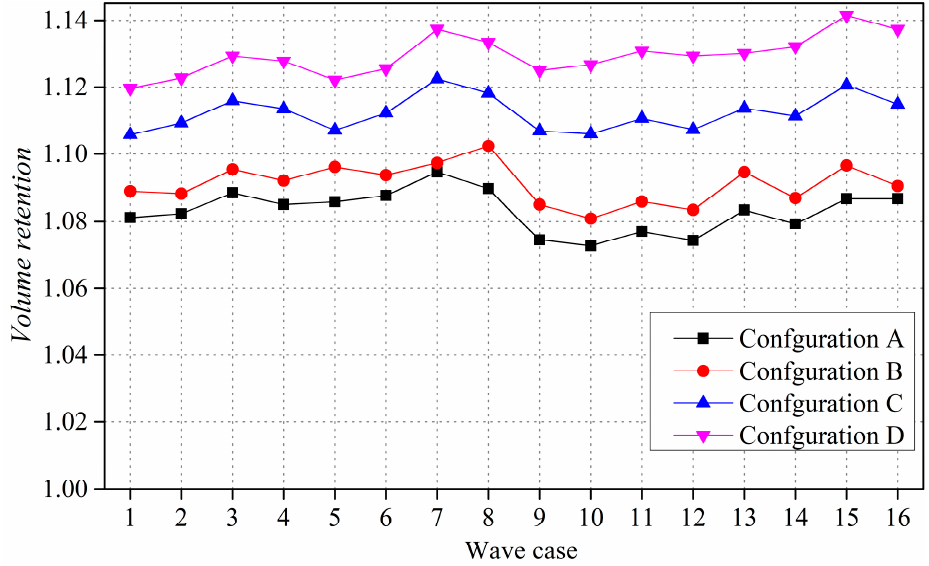
Figure 16. Volume retention for Configurations A-D under waves and currents.